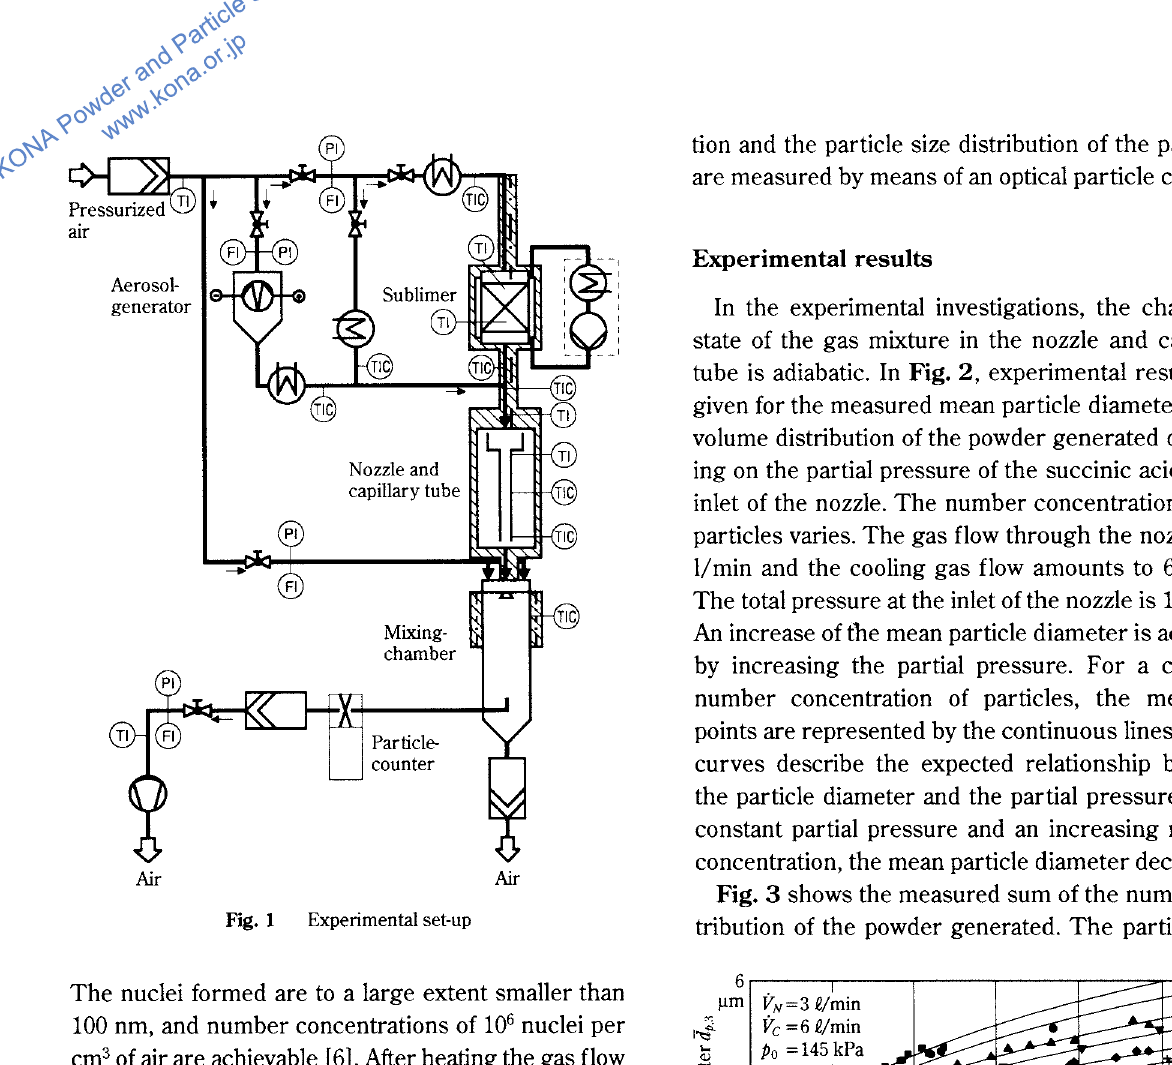
Experimental set-up